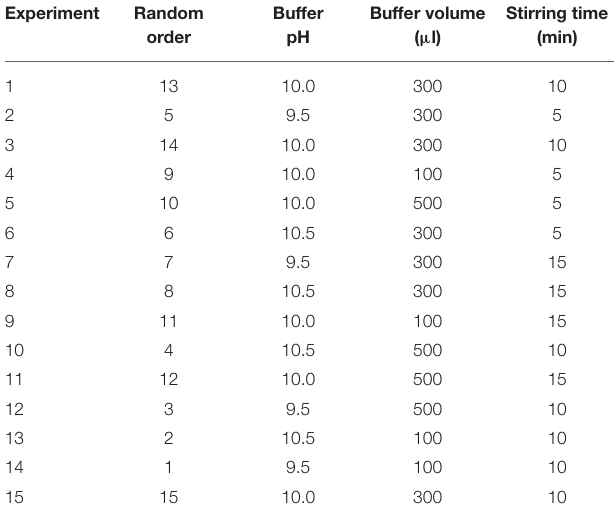
TABLE 3 | Experimental matrix for the Box–Behnken